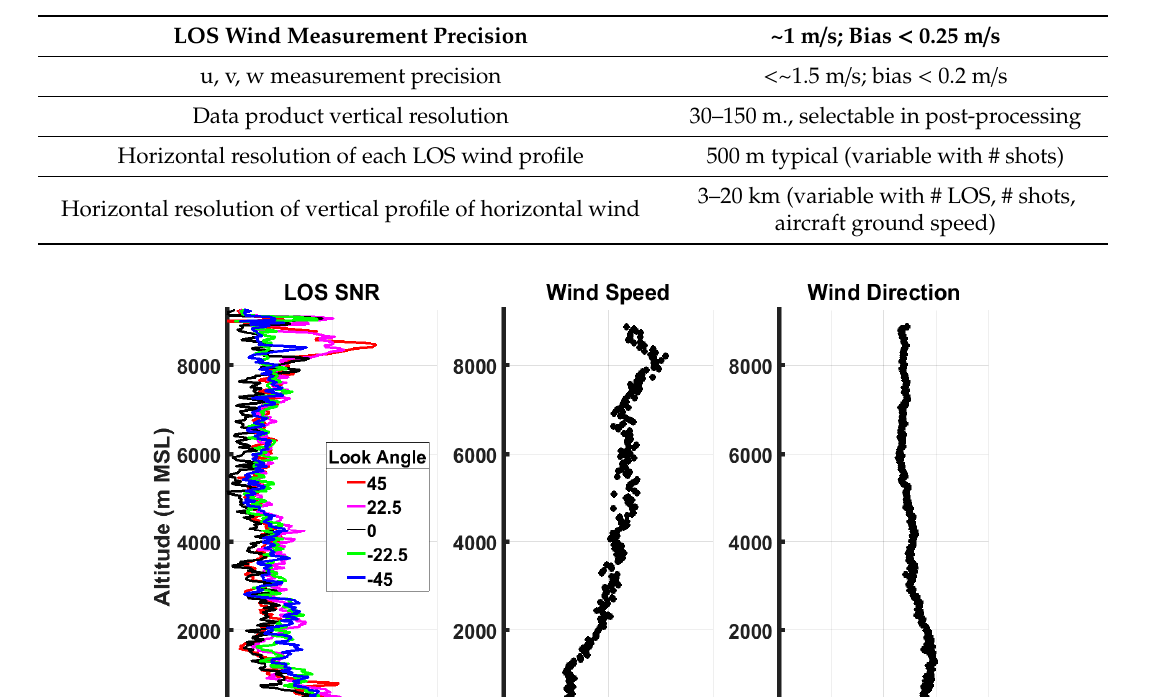
Table 5. DAWN on NASA DC-8 measurement quality and resolutions.